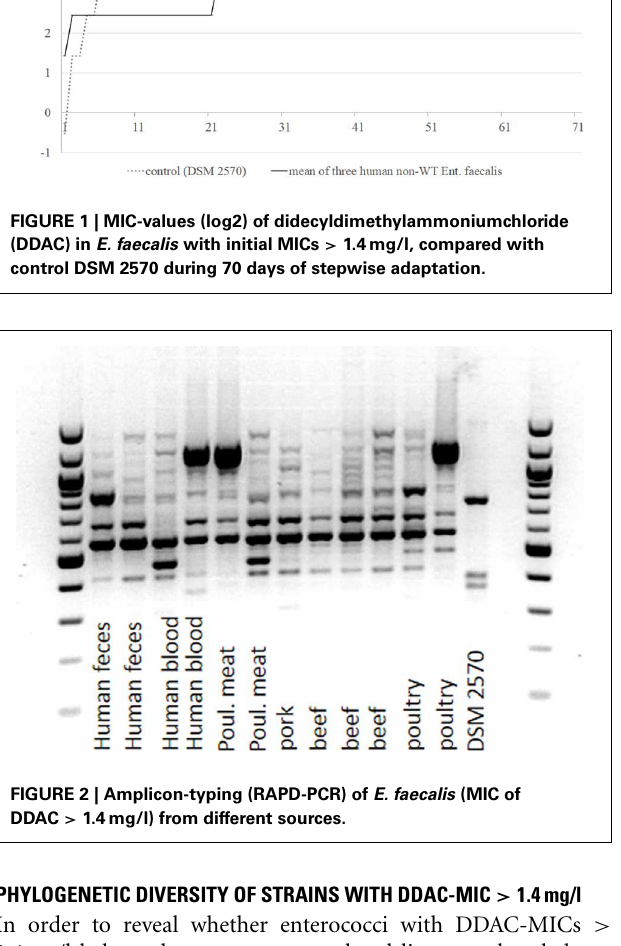
PHYLOGENETIC DIVERSITY OF STRAINS WITH DDAC-MIC > 1.4mg/l